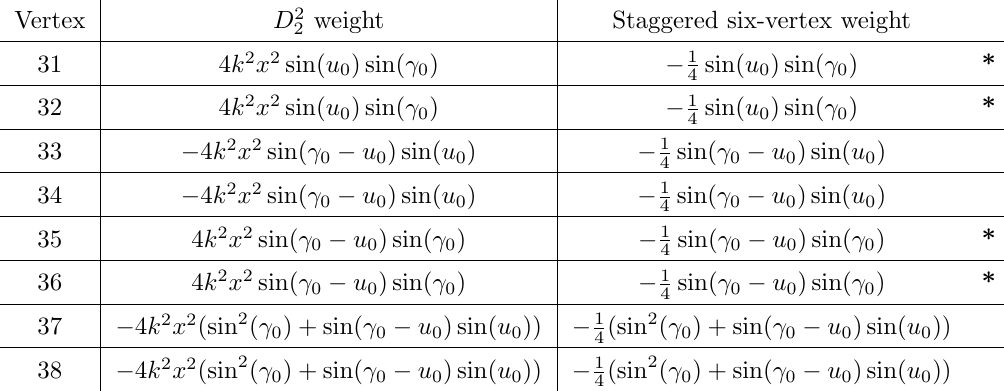
Table 3 . Correspondence between Boltzmann weights (continued). Vertices 31 to